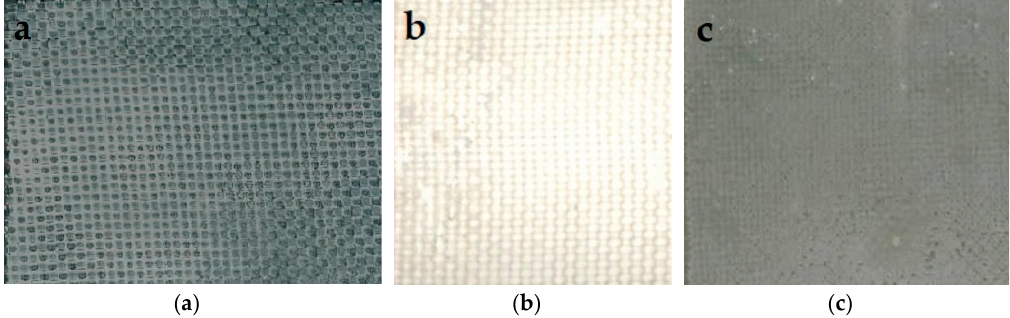
Figure 1. ( a ) Carbon fiber ( b ) E-glass fiber ( c ) Basalt fiber reinforced geopolymer composite before Table 1. Density and volume fractions of fiber, matrix, and voids of the impact test. three reinforcements used. Table 1. Density and volume fractions of fiber, matrix, and voids of the three reinforcements used. Reinforcement